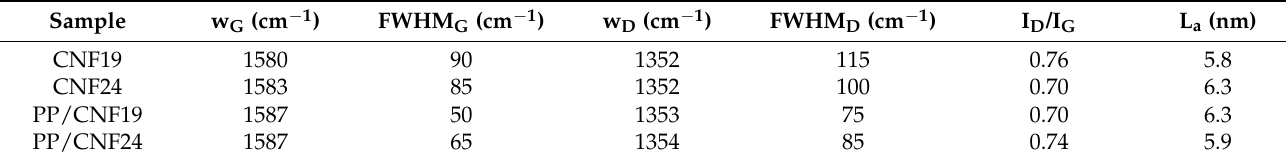
Figure 4. Raman spectra of PP, as-received CNFs and PP/CNF composites (data of PP, CNF 19 and PP/CNF19 taken with permission from ref. [15]. Data of CNF 24 taken with permission from ref. [21]). Table 2. D and G peak positions (cm − 1 ) and respective full-width half maximum FWHM (cm − 1 ). Intensity ratio between D and G bands (I D /I G ), obtained from the Raman fit, and L a (nm) in CNFs and PP/CNF composites. (Data of PP, CNF 19 and PP/CNF19 taken with permission from ref. [15]. Data of CNF 24 taken with permission from ref. [21]).